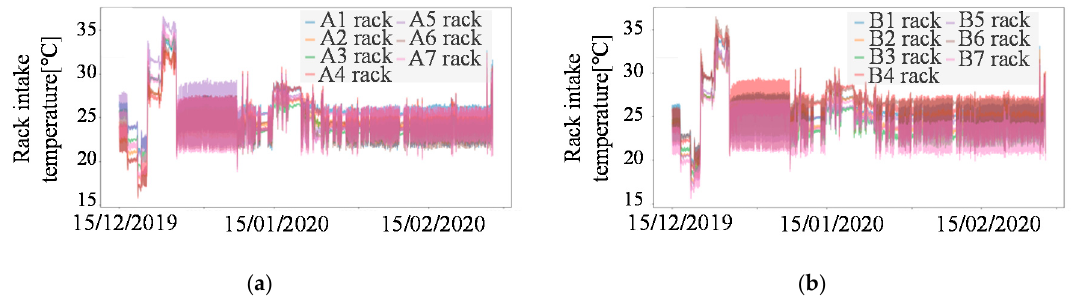
Figure 9. Time-series change of rack intake temperature in each rack row. ( a ) Rack intake temperature in A rack row. ( b ) Rack intake temperature in B rack row.